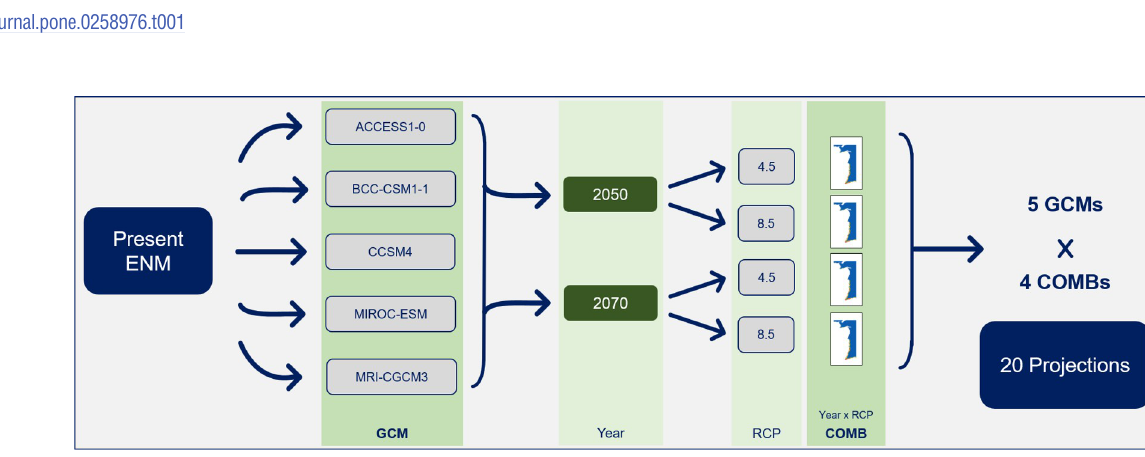
Fig 2. Methodological workflow for the projections of the Ecological Niche Model (ENM) into the future, for five General Circulation Models (GCMs). For each GCM, four combinations (COMBs) of years (2050 and 2070) and Representation Concentration Pathways (RCPs; 4.5 and 8.5) were